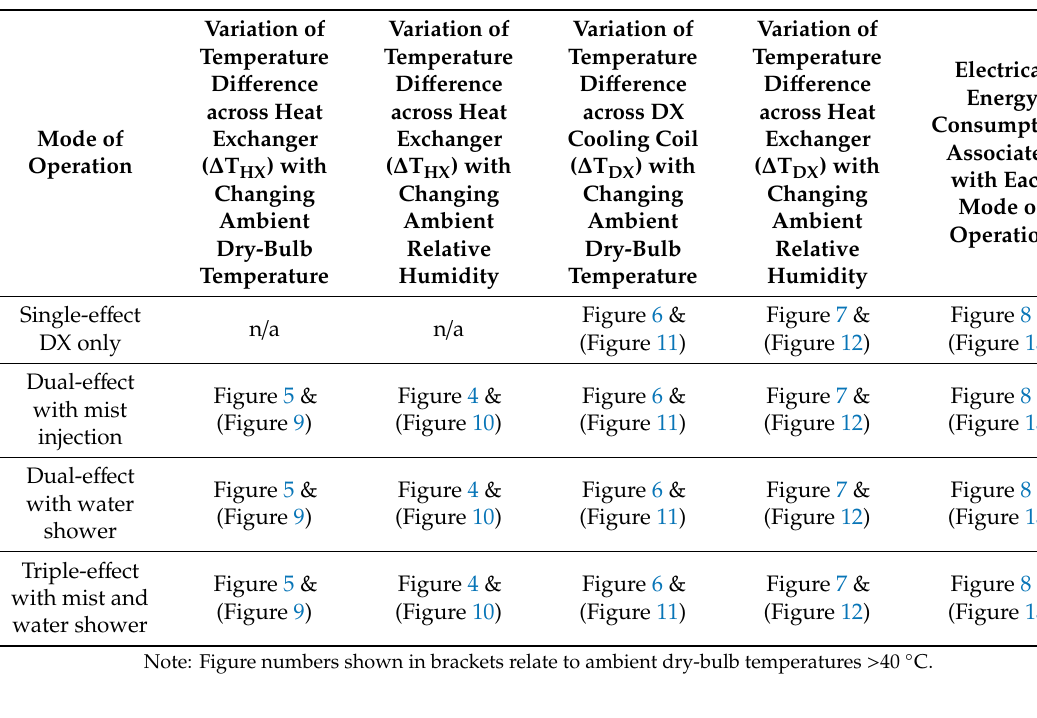
Table 2. Schedule of cases analyzed to be used for comparing di ff erent modes of operation.